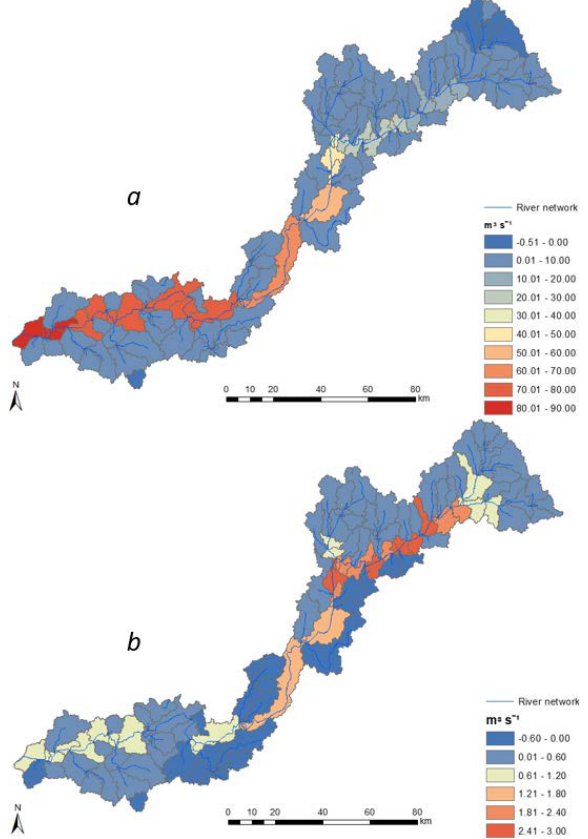
Figure 5: Change in average annual sub-watershed flow, 2002- 2010 ( a ) and 2010-2016 ( b